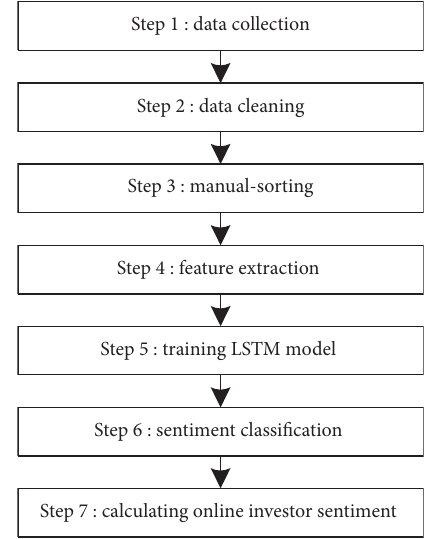
Figure 1: The steps of development of online investor